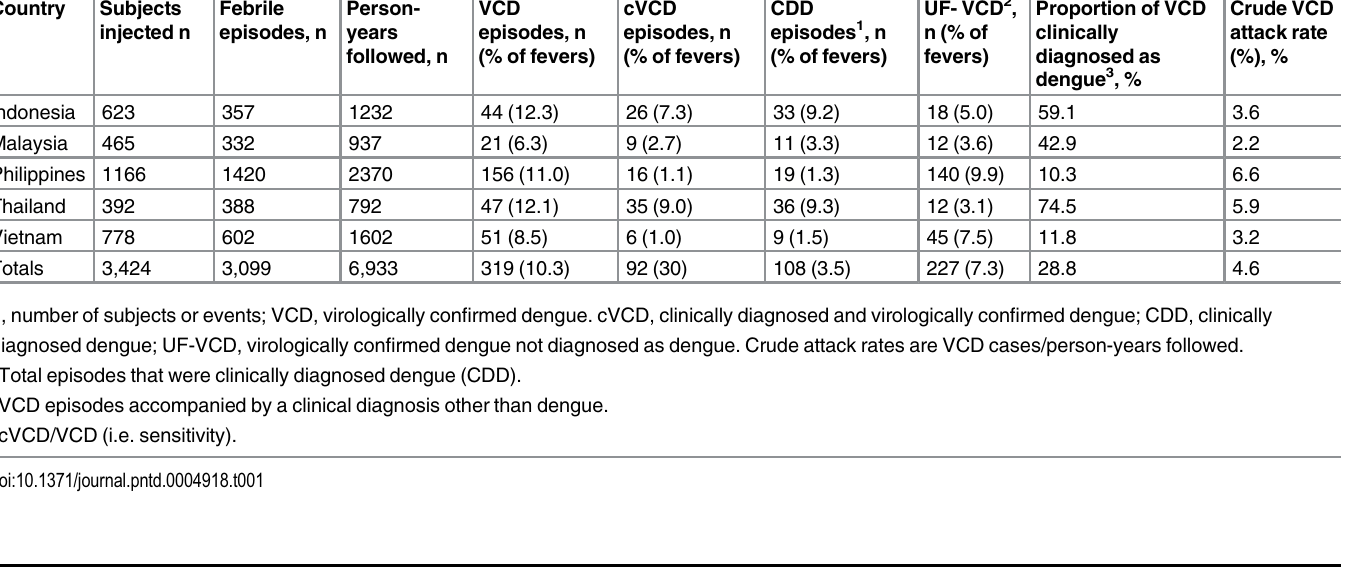
Table 1. Number (n) and proportion of subjects experiencing episodes satisfying different case definitions in the CYD14 control arm, June 2011 – December 2013. Country Subjects injected